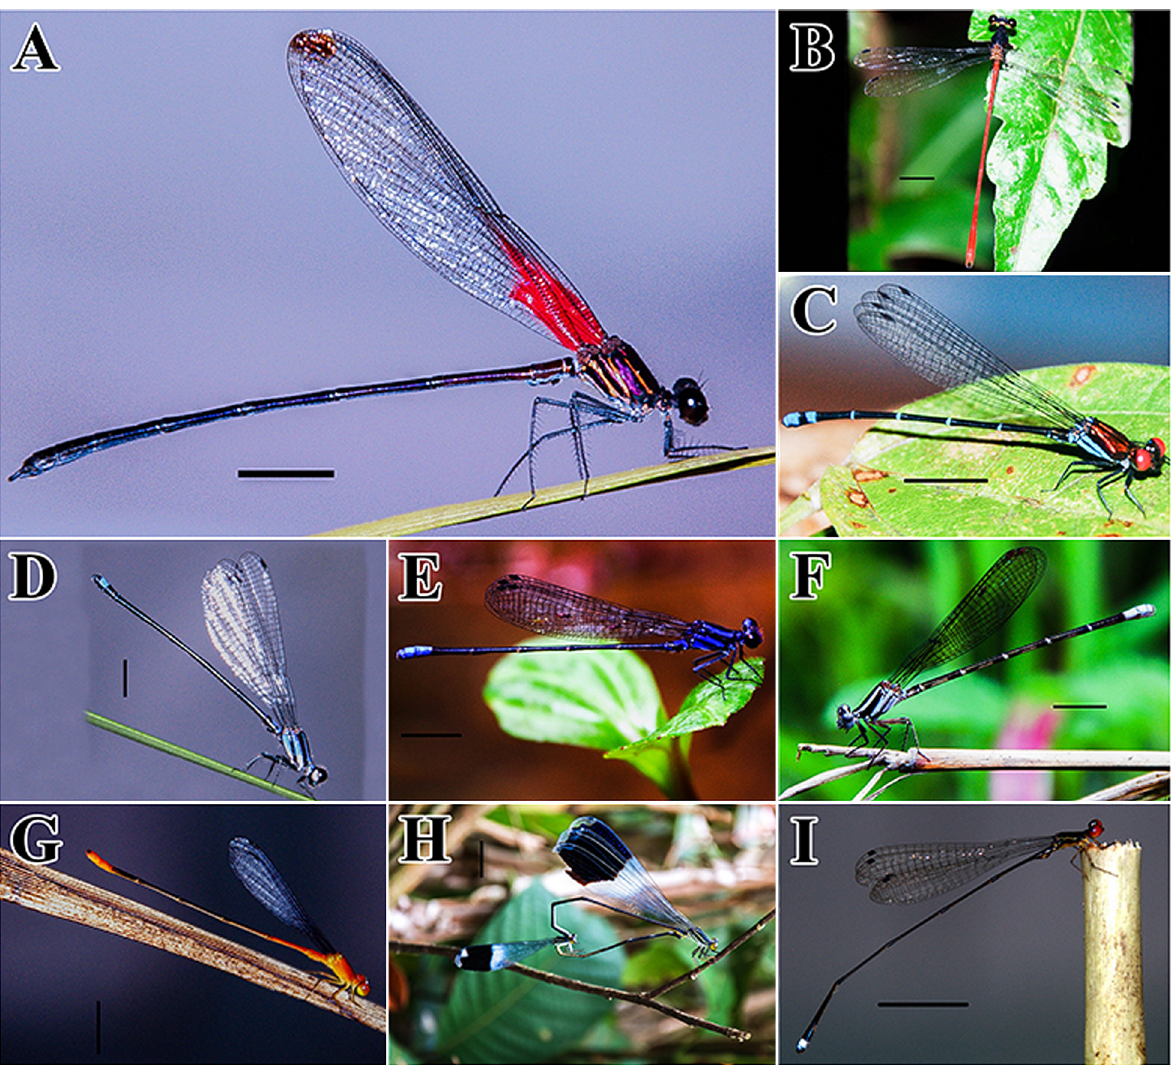
Figure 3. Zygoptera species from Bahia Solano. A. Hetaerina fuscoguttata . B. Heteragrion erythrogastrum C. Argia fulgida . D. Argia indica- trix . E. Argia pulla male. F. Argia pulla female. G. Leptobasis vacillans H. Megaloprepus coerulatus . I. Psaironeura angeloi . Scale bars = 1